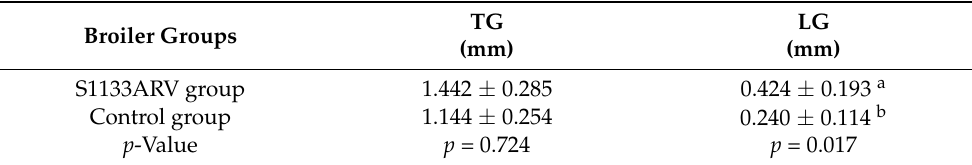
Table 4. Histological measurements of the proventricular gland from broiler chickens vaccinated with the S1133 reovirus